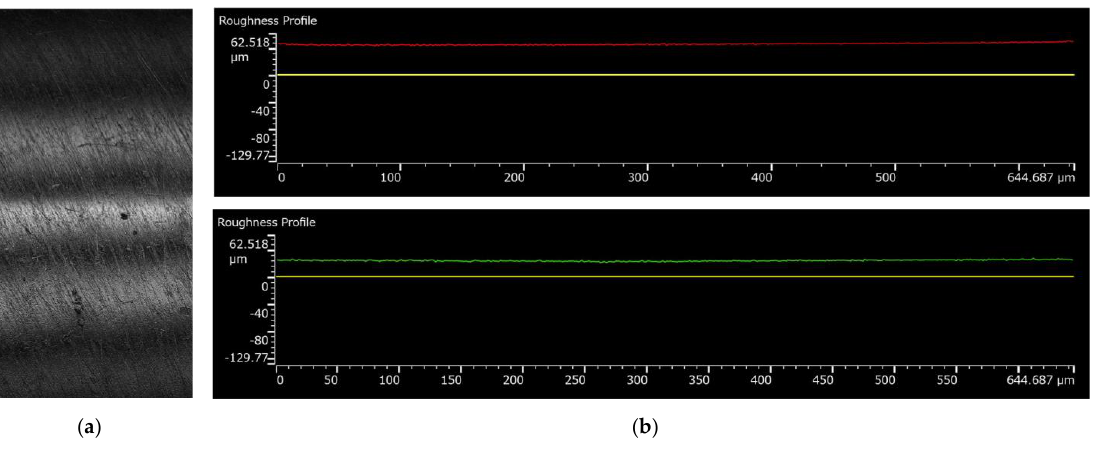
Figure 5. The quality of SLM specimen surface after polishing ( a ) scan view and ( b ) profile meas- urements.